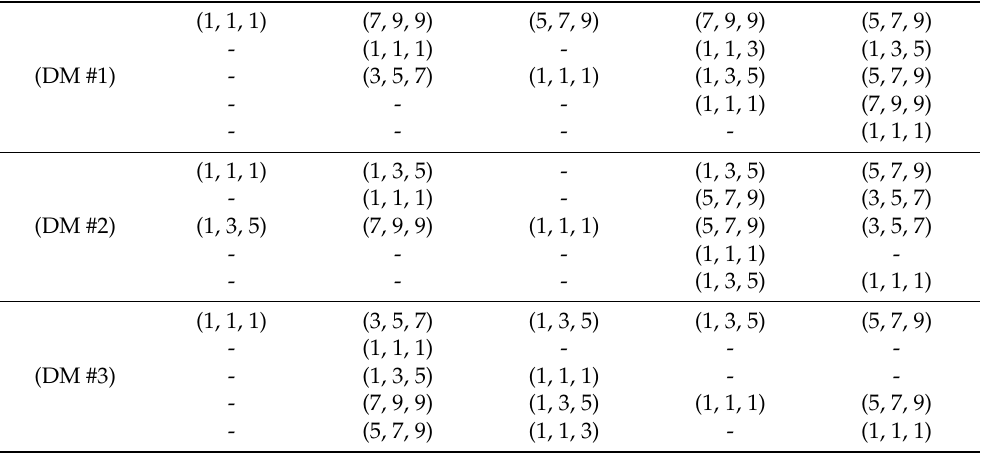
Table 1. The fuzzy pairwise comparison matrixes constructed for the decision-makers (DMs).